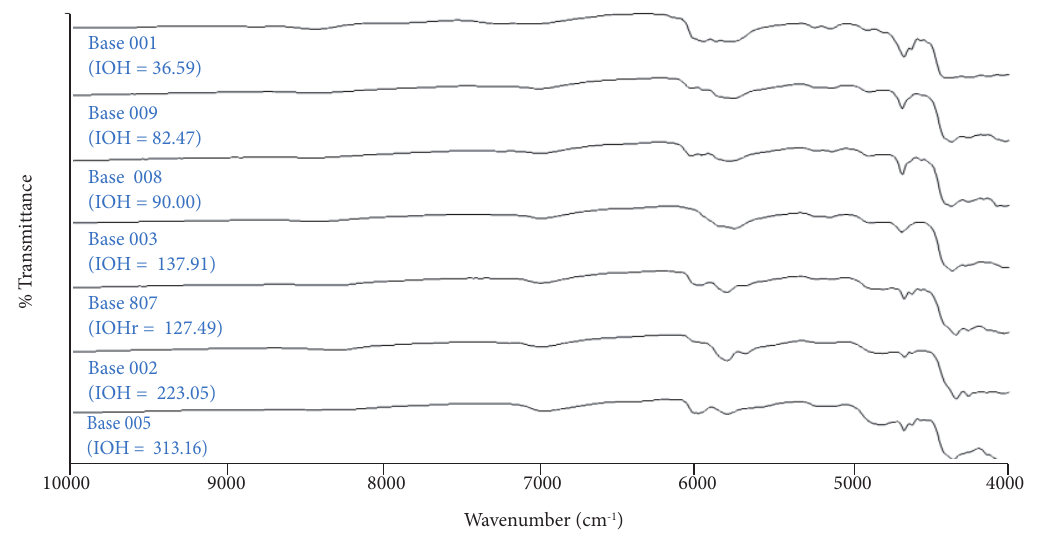
Figure 12. FT-IR/NIRA spectra of polyesters (IOH in mg KOH/g), analyzed as received. Figure 13. FT-IR/NIRA calibration curve of A 7000 versus IOH in mg KOH/g (measured by wet chemistry method, supplier’s data). FT-IR/NIRA = Fourier transform infrared/Near infrared reflection analysis; IOH = Hydroxyl number; KOH = Potassium